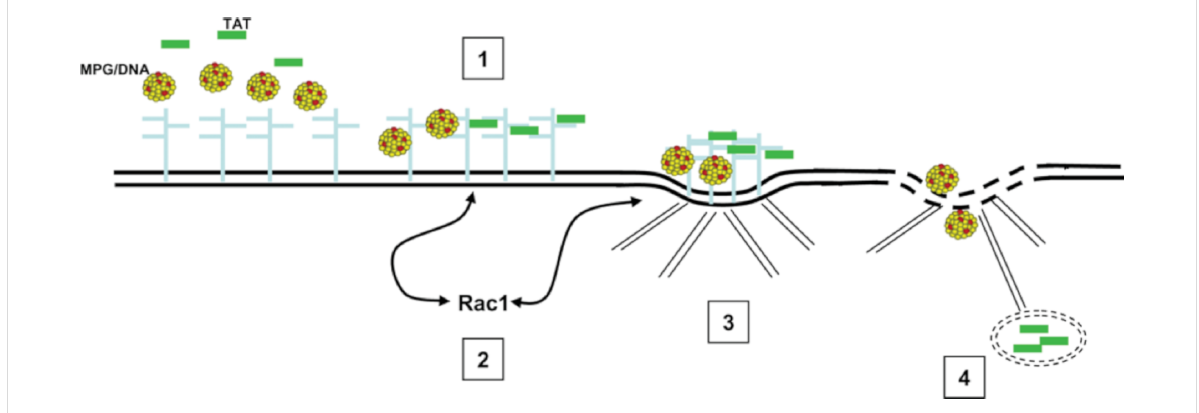
Figure 2: Model for the initial step of cellular uptake of MPG or MPG/cargo complexes. (1) Binding of MPG or MPG/cargo to the extracellular matrix via the proteoglycan platform; (2) clustering of glycosaminoglycans (GAGs), which in turn activates the Rac1 GTPase; (3) actin network remodeling; (4) increase of membrane fluidity, promoting MPG uptake. Reprinted with permission from [32], copyright 2007 The Royal Society of